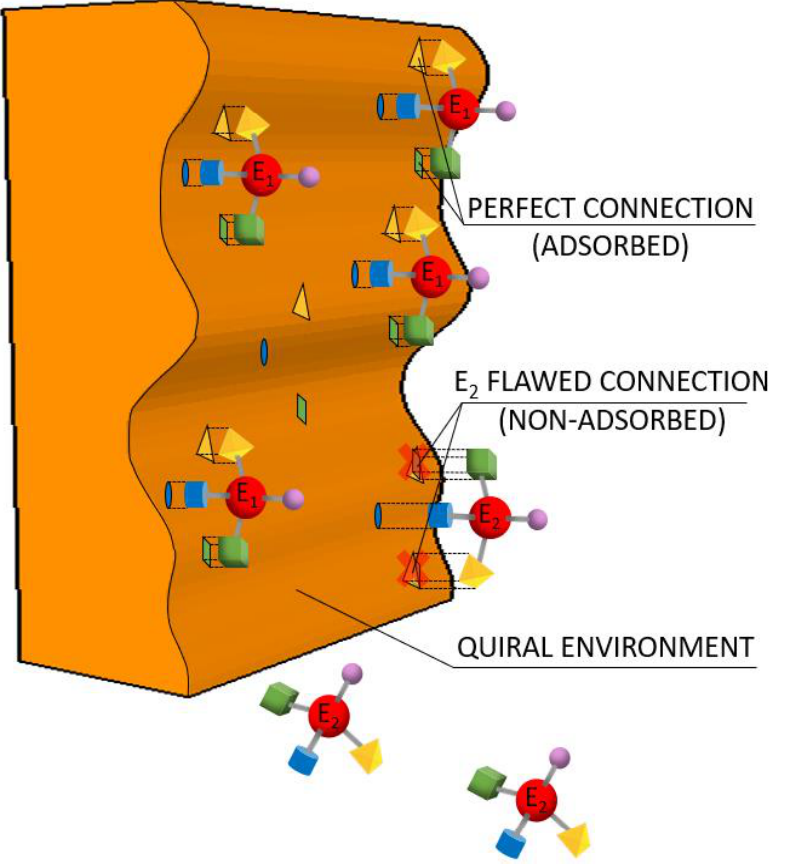
Figure 12. Adsorbed Enantiomer 1 (E1) onto the chiral environment according to Dalgliesh’s three- point rule and non-absorbed Enantiomer 2 (E2).